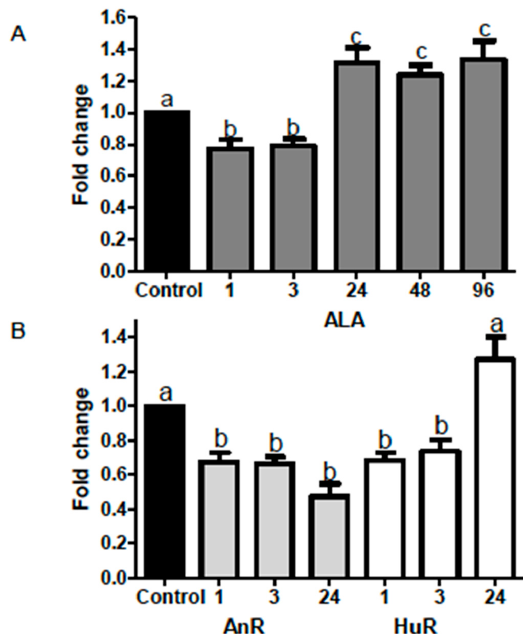
Figure 2. ( A ) Effect of ALA on miR-21 expression after 1, 3, 24, 48 and 96 h treatment (dark